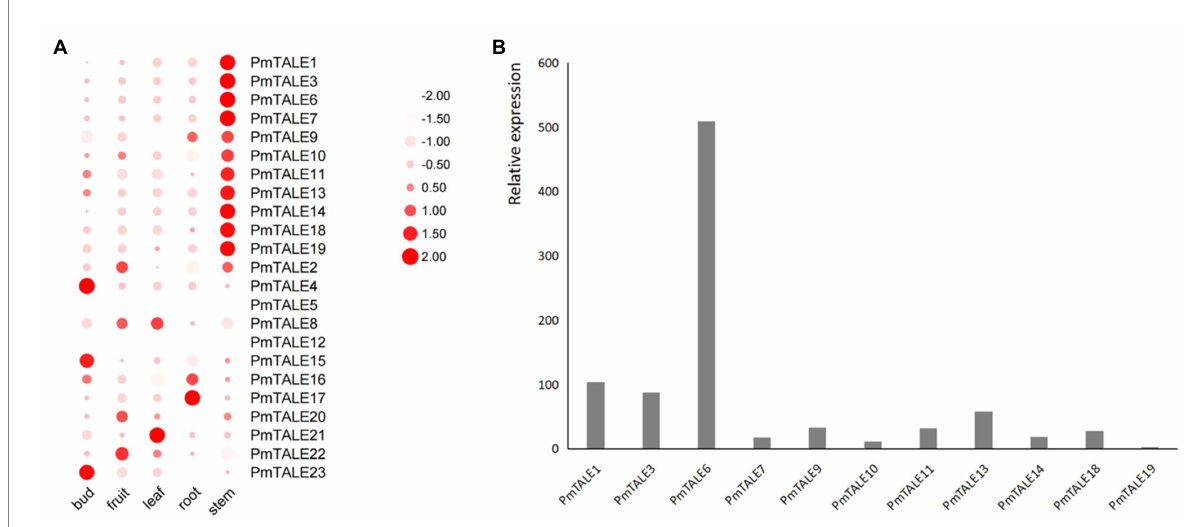
FIGURE 11 Expression profiling of the Prunus mume TALE gene family based on RNA sequencing results. (A) The heatmap parameters are set to: row scale and scale size by area; (B) Relative expression levels of some TALE genes in stem. The abscissa represents the 11 TALE genes that are specifically highly expressed in the stem, and the ordinate represents the relative expression of genes in the